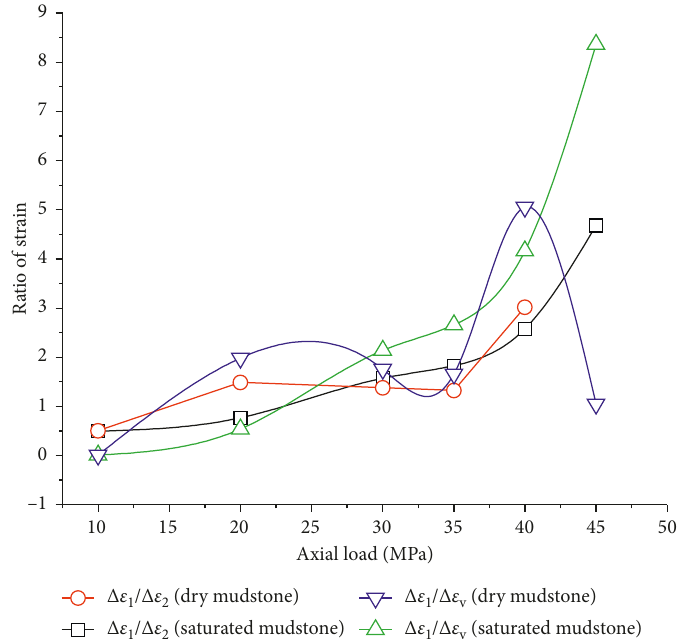
Figure 6: Ratio of strain against axial load.